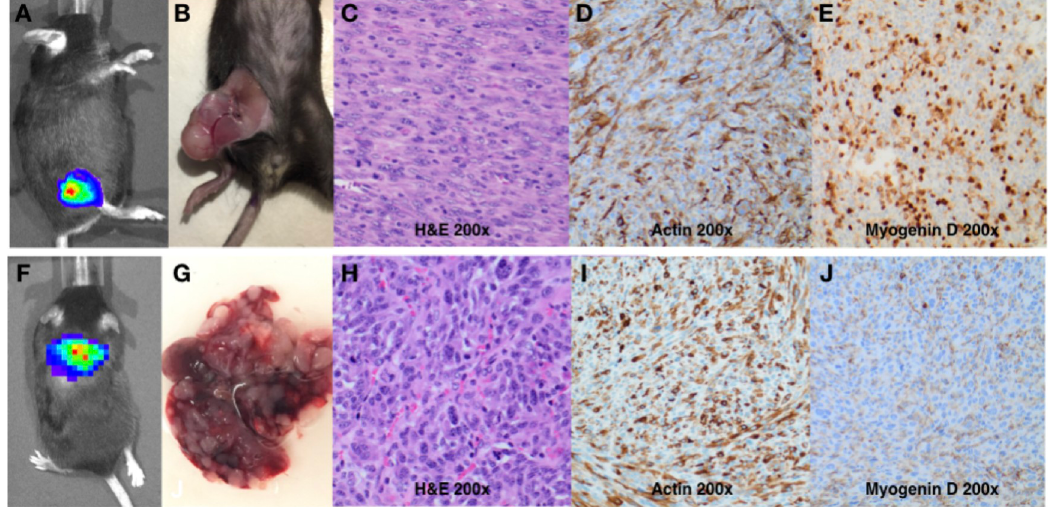
Fig 3. Cell lines derived from spontaneous UPS tumours are easily engrafted in the hindlimb and lung of na ï ve, immunologically competent C57Bl/6 mice. (A-B) Following injection of 100,000 UPS cells into the hindlimb of C57Bl/6 mice, tumours are detectable via bioluminescence imaging and result in large palpable tumours by three weeks. (C-E) Routine histology and immunohistochemistry of cell line derived tumours is consistent with UPS and similar to spontaneous UPS tumours. (F-G) Tail vein injections result in bioluminescence detectable tumours in the lung with multiple tumour lung nodules on gross examination of lung tissue. (H-J) Routine histology and immunohistochemistry of cell line derived lung tumours is consistent with UPS and similar to spontaneous UPS